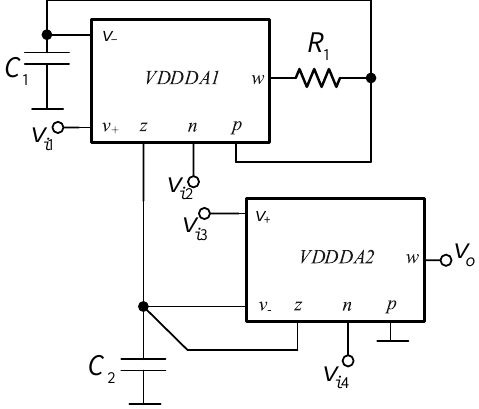
Figure 5. The universal filter based on the VDDDA.